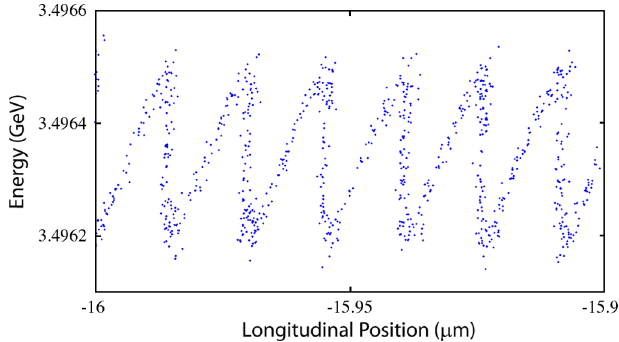
FIG. 5. A zoom of Fig. 4 shows the compressed modulation bunched to optimize higher harmonics. The vertical stripes (‘‘standing up’’ the modulation) in phase space produce sharp density spikes that drive harmonic generation. The T 566 compo- nent of the transfer matrix causes slight